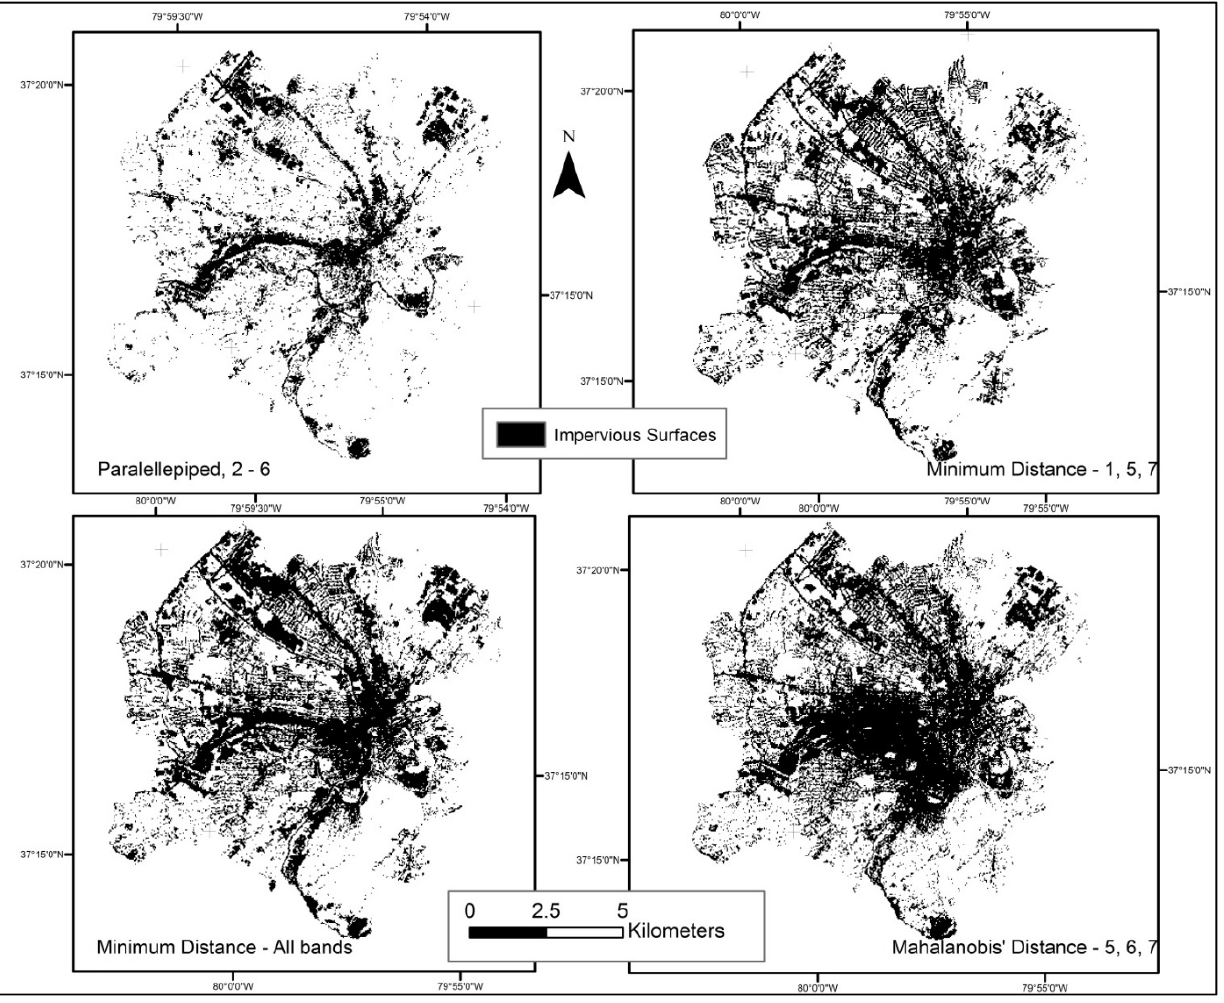
Figure 3. Impervious surfaces as classified by four